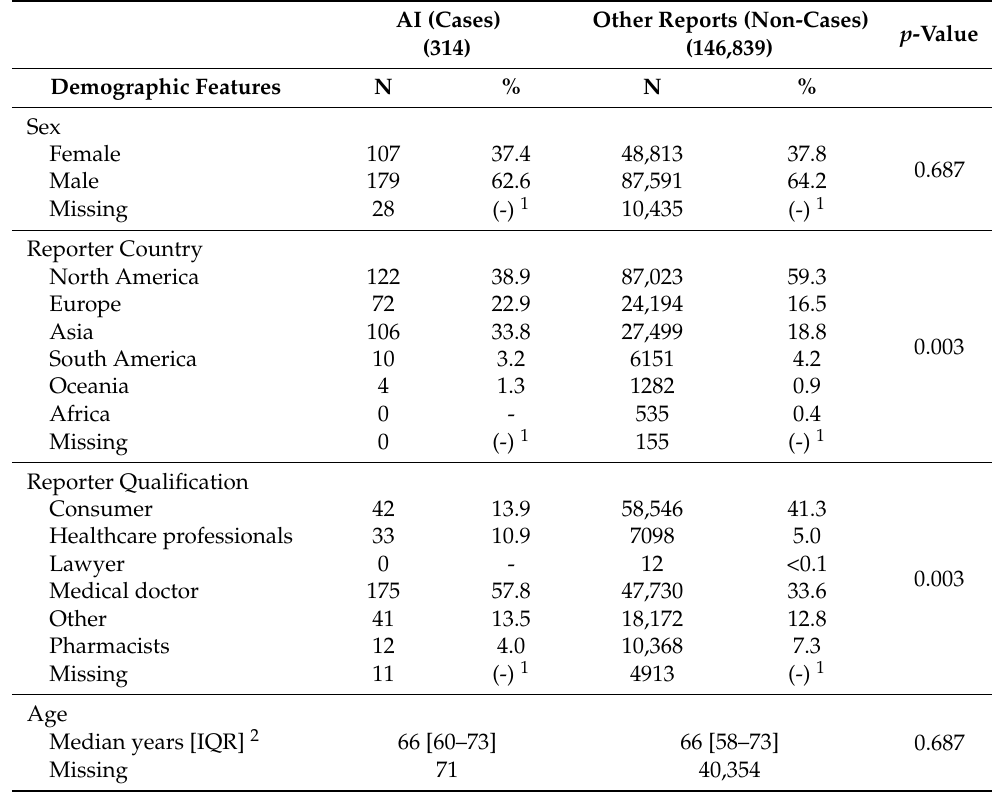
Table 1. Demographic data on adrenal insufficiency (AI) with VEGFR-TKIs.